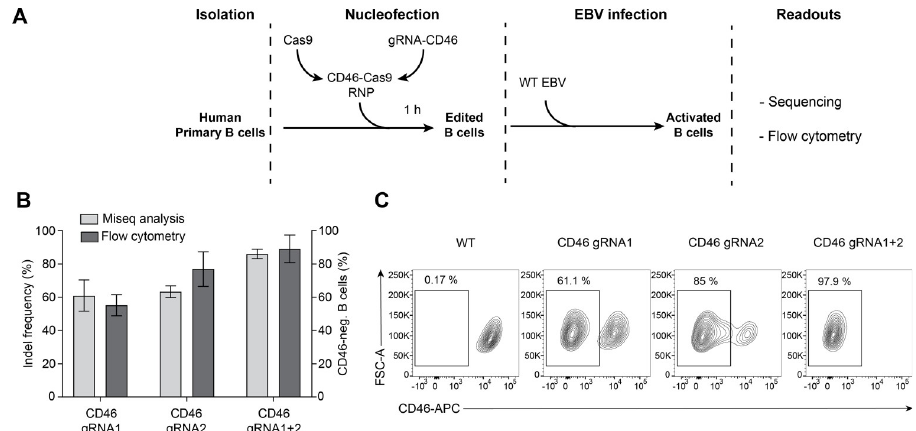
Fig 1. Targeting the locus of the cell surface protein CD46 in primary human B cells. (A) Schematic overview of the delivery of CD46-Cas9 RNP complexes to primary human B cells by nucleofection. 2 × 10 6 primary human B cells were nucleofected with RNP complexes assembled with a two-component guide RNA (gRNA) protocol using tracrRNA, crRNA and recombinant Streptococcus pyogenes Cas9 nuclease. The cells recovered for 1 h after nucleofection before they were infected with wild-type (WT) EBV. The efficiency of gene editing was analyzed at the level of nucleotide sequence and surface protein. (B) Indel frequencies derived from next generation sequencing analysis of the second exon of the CD46 gene are shown together with flow cytometry analysis of CD46 protein expression from all investigated samples. Cells were nucleofected with individual Cas9 RNP complexes (gRNA1 or 2) or concomitantly with both complexes and were analyzed 1 week later. Mean and standard deviation from four independent biological replicates are shown. (C) Flow cytometry analysis of CD46 surface staining of living cells treated with two RNP complexes 1 week post